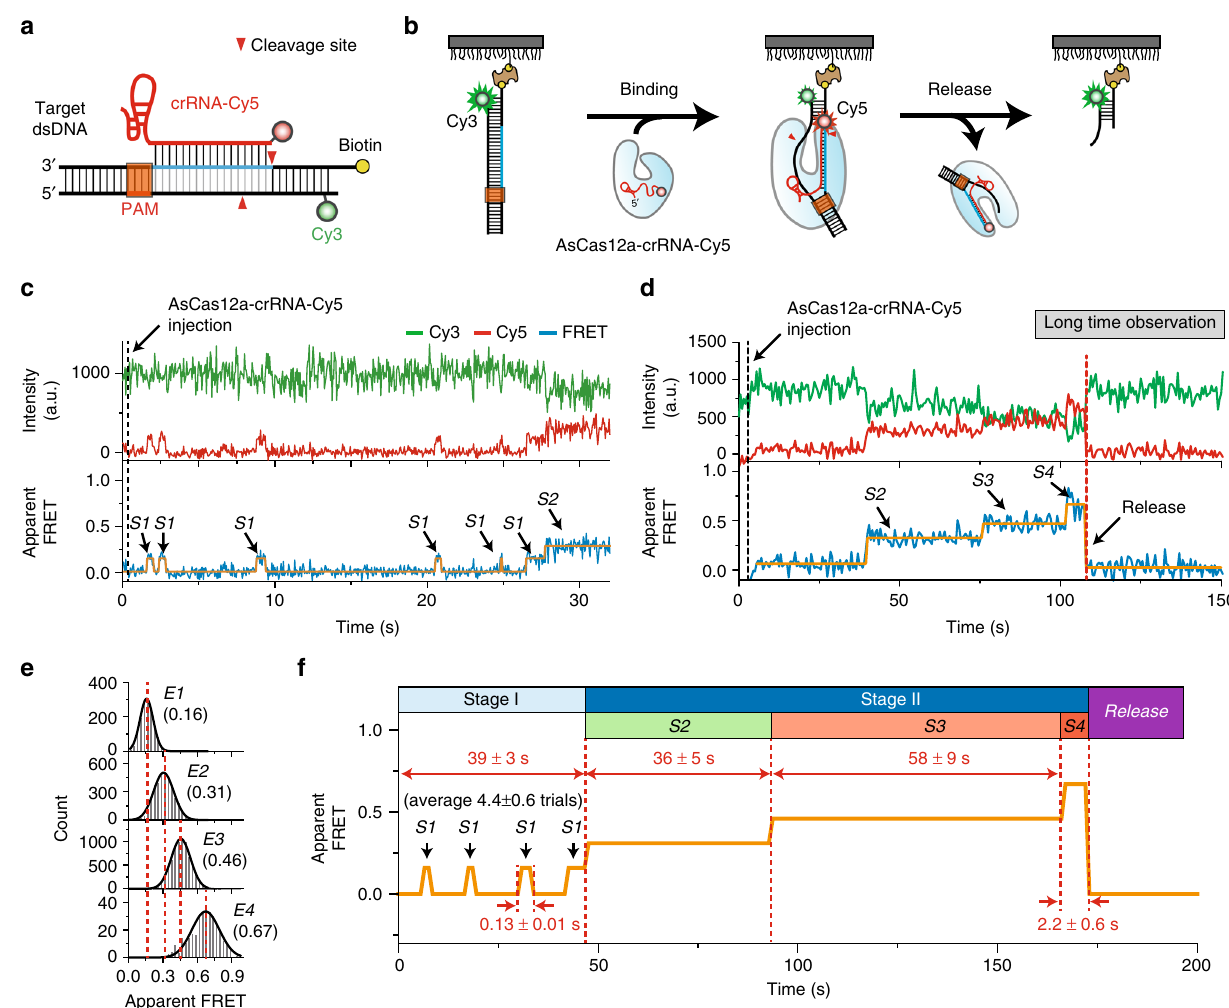
Fig. 2 Direct observation of DNA cleavage by AsCas12a RNP. a The standard design of target DNAs and crRNAs used in the experiments. b Schematic diagram of the single-molecule FRET experiment used to monitor the AsCas12a cleavage reaction. c , d Representative time traces of Cy3 fl uorescence (green, top), Cy5 fl uorescence (red, top), and corresponding FRET ef fi ciency (blue, bottom) showing the short-lived weak binding of AsCas12a RNP to target DNA ( c ) and the stable binding with subsequent FRET changes ( d ). To clearly visualize transitions, orange lines were added as an eye guide. The same color conventions are used throughout the paper. These experiments were performed under the same reaction conditions except for the time resolution. In c , a time resolution of 50-ms was used to clearly detect the short-lived binding events. In d , a time resolution of 500-ms was used instead to reduce the photobleaching of the fl uorophores for long-time observation. e FRET histograms of individual reaction steps. FRET values for each step were obtained by fi tting the FRET histograms to a single Gaussian function. To obtain the FRET histograms, all data points for each state were collected from at least more than 45 time trajectories (65 for E1; 63 for E2 and E3; and 45 for E4). f Representative scheme of a time trace showing both short- and long- lived binding events and the subsequent FRET changes accompanying the fi nal release of the cleavage